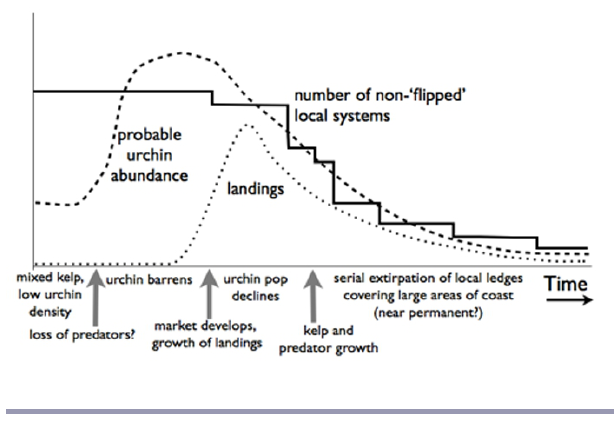
Fig. 2 . In the traditional broad-scale view, state-wide landings occurred at a faster rate than that of the population, leading to declines in population and landings (dashed lines). Slowing the broad-scale rate of harvest is the implied policy. In an alternative view, emphasizing finer scale ecology, the mechanism leading to a decline in the population and harvests was the serial extirpation (flip) of numerous ledges (solid line), i.e., small local “systems”. The implied policy would be one that addresses the system state on each ledge.